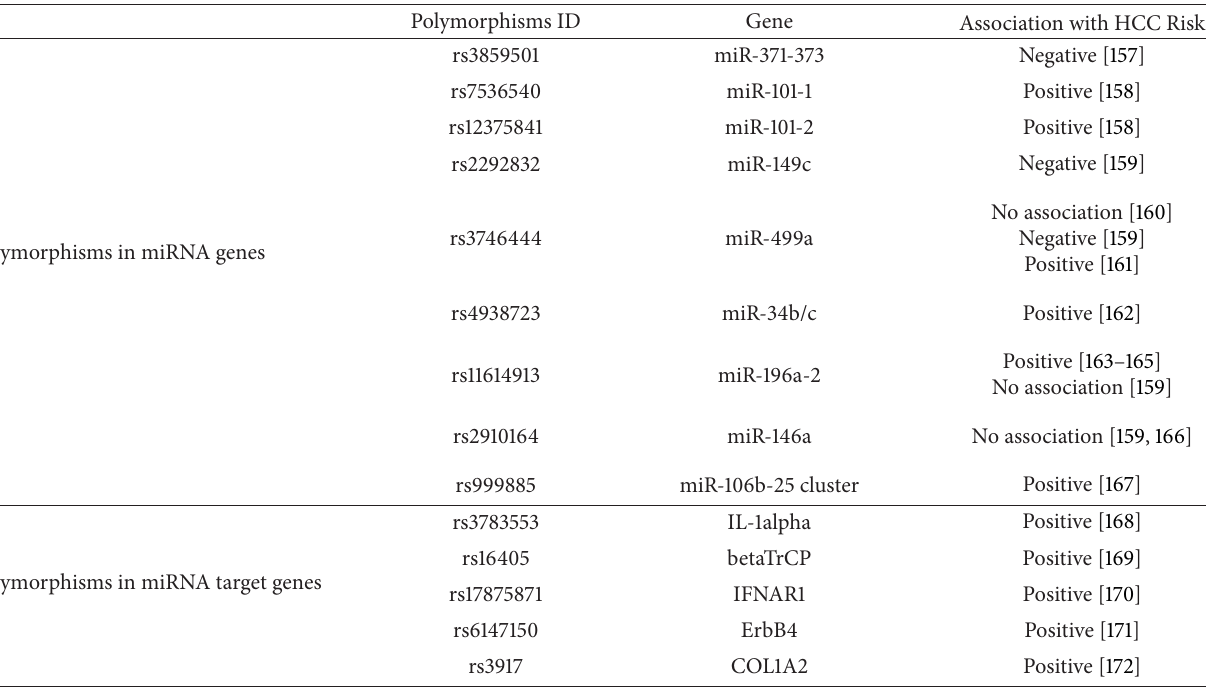
Table 2: SNPs in miRNAs and their target genes and the association with risk of